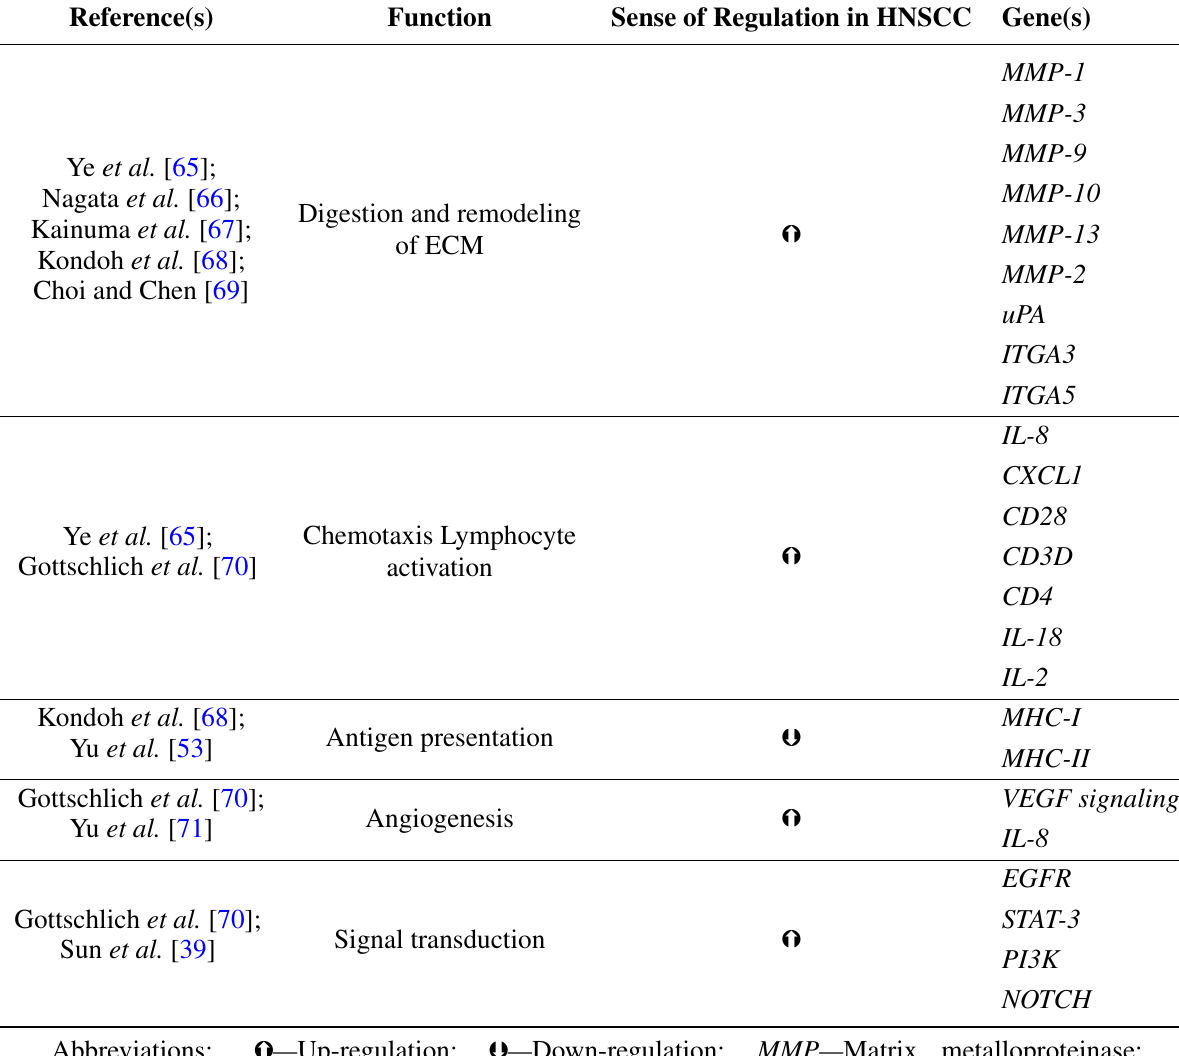
Table 1. Summary of illustrative findings related to invasiveness from gene-expression profiling studies in HNSCC.